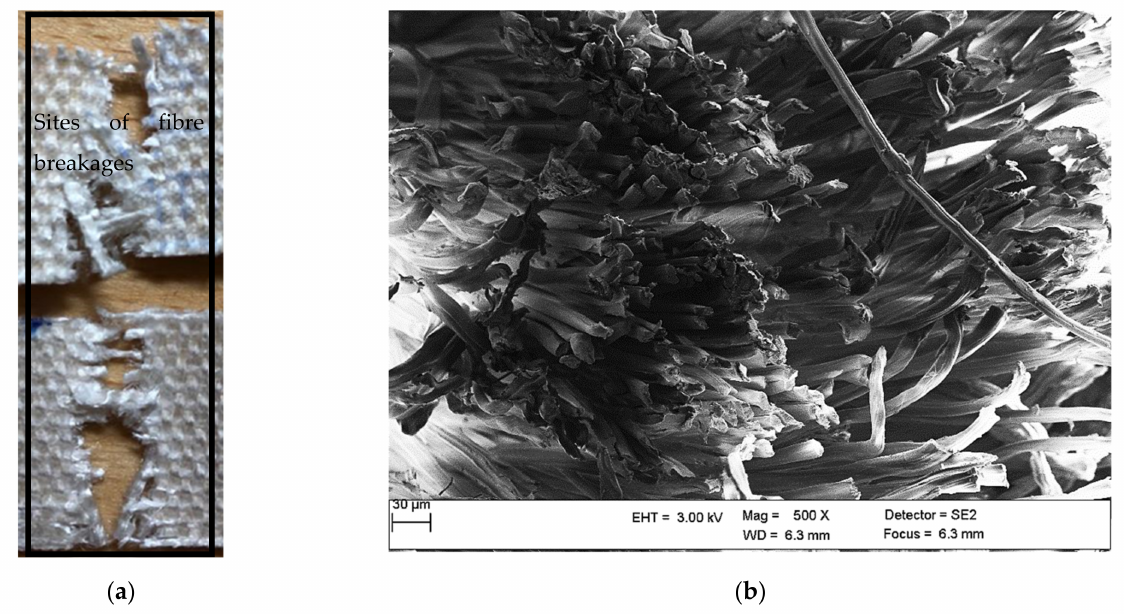
Figure 1. ( a ) Digital image and ( b ) cross-sectional SEM micrographs of the fractured rayon composite sample after tension at 500 ×